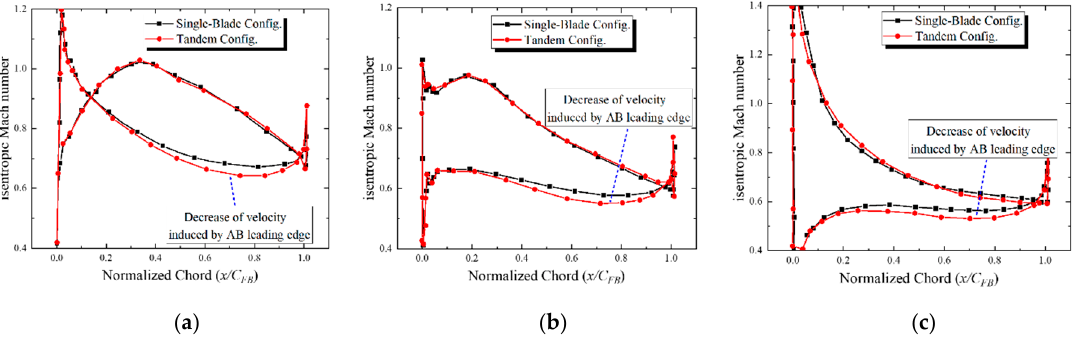
Figure 8. Comparison of the FB isentropic Mach number in single-blade and tandem configurations. ( a ) Incidence = − 5°; ( b ) incidence = − 1°; ( c ) incidence = +5°.